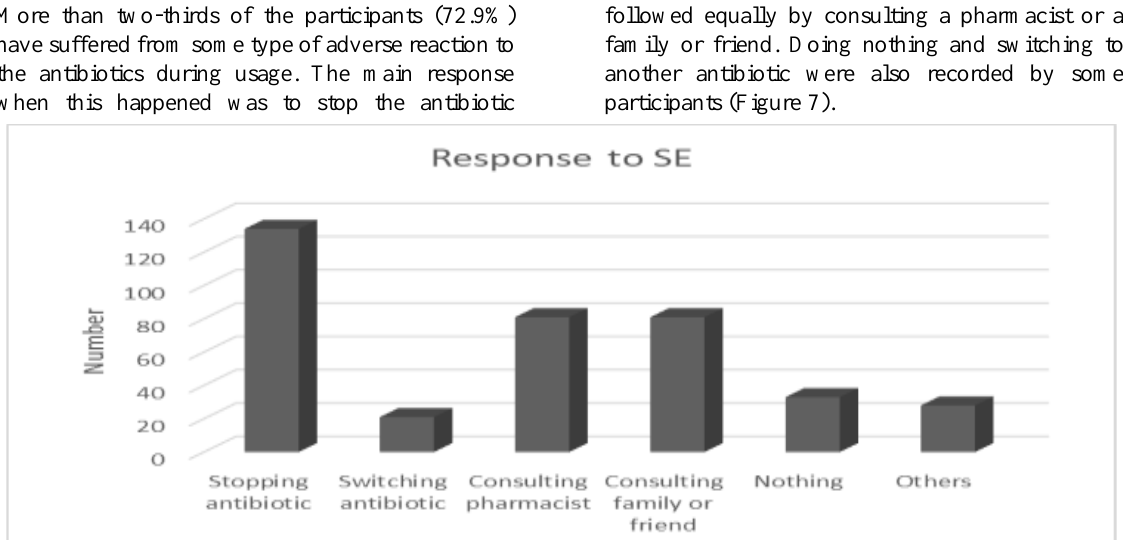
Figure 7. Response to side